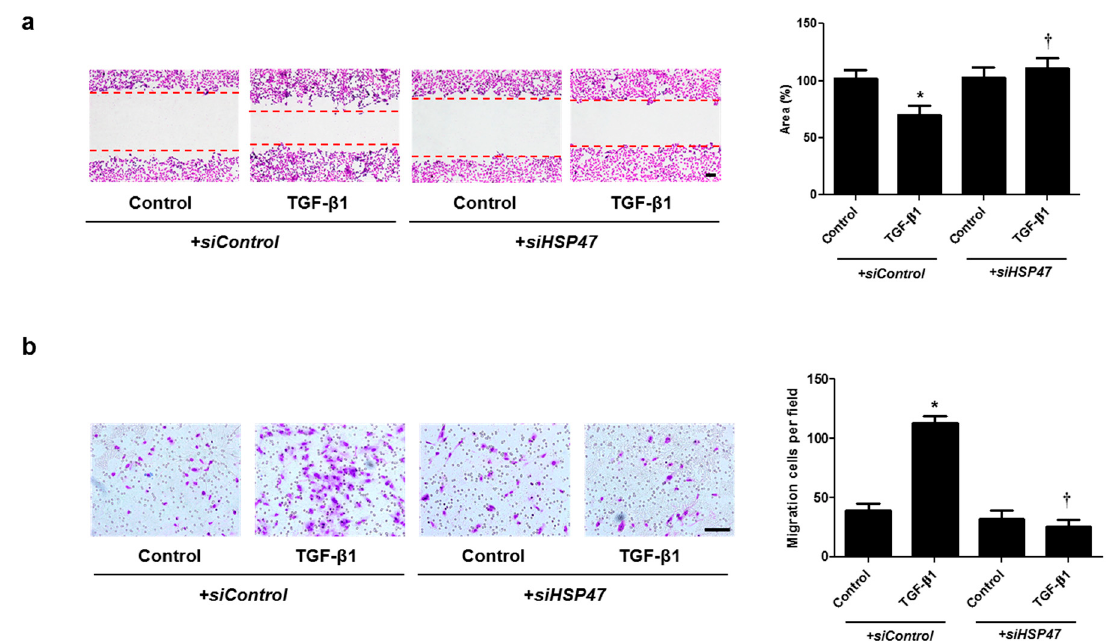
Figure 6. Silencing of HSP47 expression contributed to A549 cell migration. A549 cells were seeded and transfected with siControl or siHSP47 before treatment with TGF- β 1 for 72 h. ( a ) A wound scratch migration assay was performed to investigate the migration of A549 cells. Microscopic observation was performed 72 h after scratching the surface of a confluent layer of cells. ( b ) Inhibitory effects of siHSP47 are shown using a transwell migration assay. Scale bar = 100 µ m. Data are expressed as the mean ± SEM of three independent experiments. * p < 0.05, vs. control + siControl ; † p < 0.05, vs. TGF- β 1 + siControl